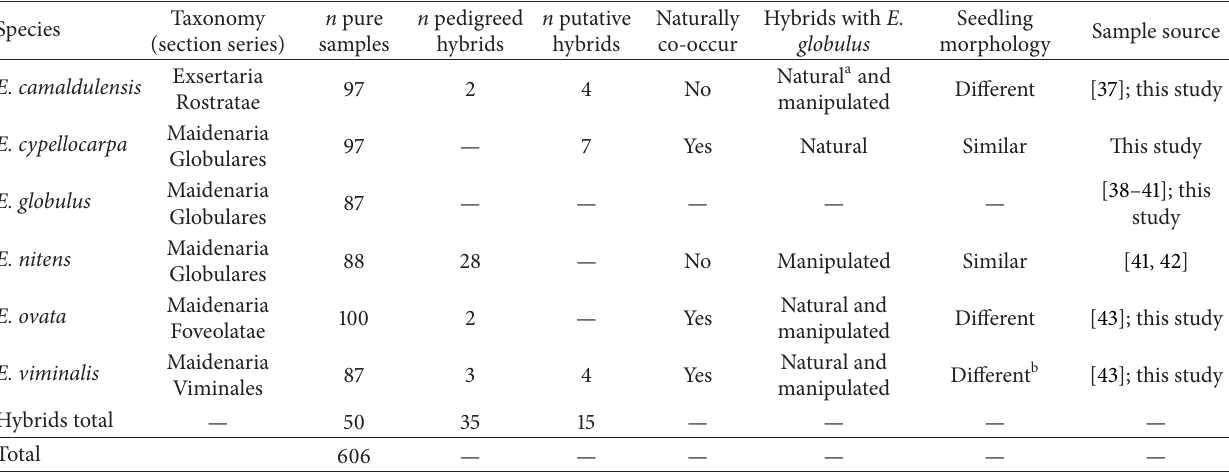
Table 1: Summary of samples used to create range wide microsatellite databases for six Eucalyptus species in order to develop a model for identifying hybrids with E. globulus . All the species are members of the subgenus Symphyomyrtus, and their lower level taxonomy is given according to Euclid [12]; see Appendix 1 for more details. Also given for each species is the number of pure samples; the number of pedigreed and putative hybrid samples with E. globulus ; their co-occurrence with E. globulus ; reported hybrids with E. globulus ; the similarity in their seedling morphology to E. globulus ; and the source of